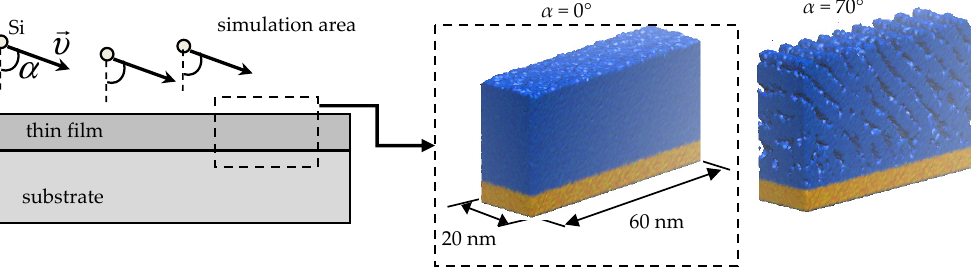
Figure 1. To the description of the simulation of thin film growth, α is the deposition angle.